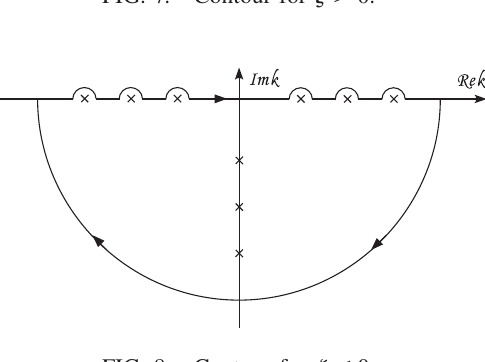
FIG. 7. Contour for (cid:14) > 0